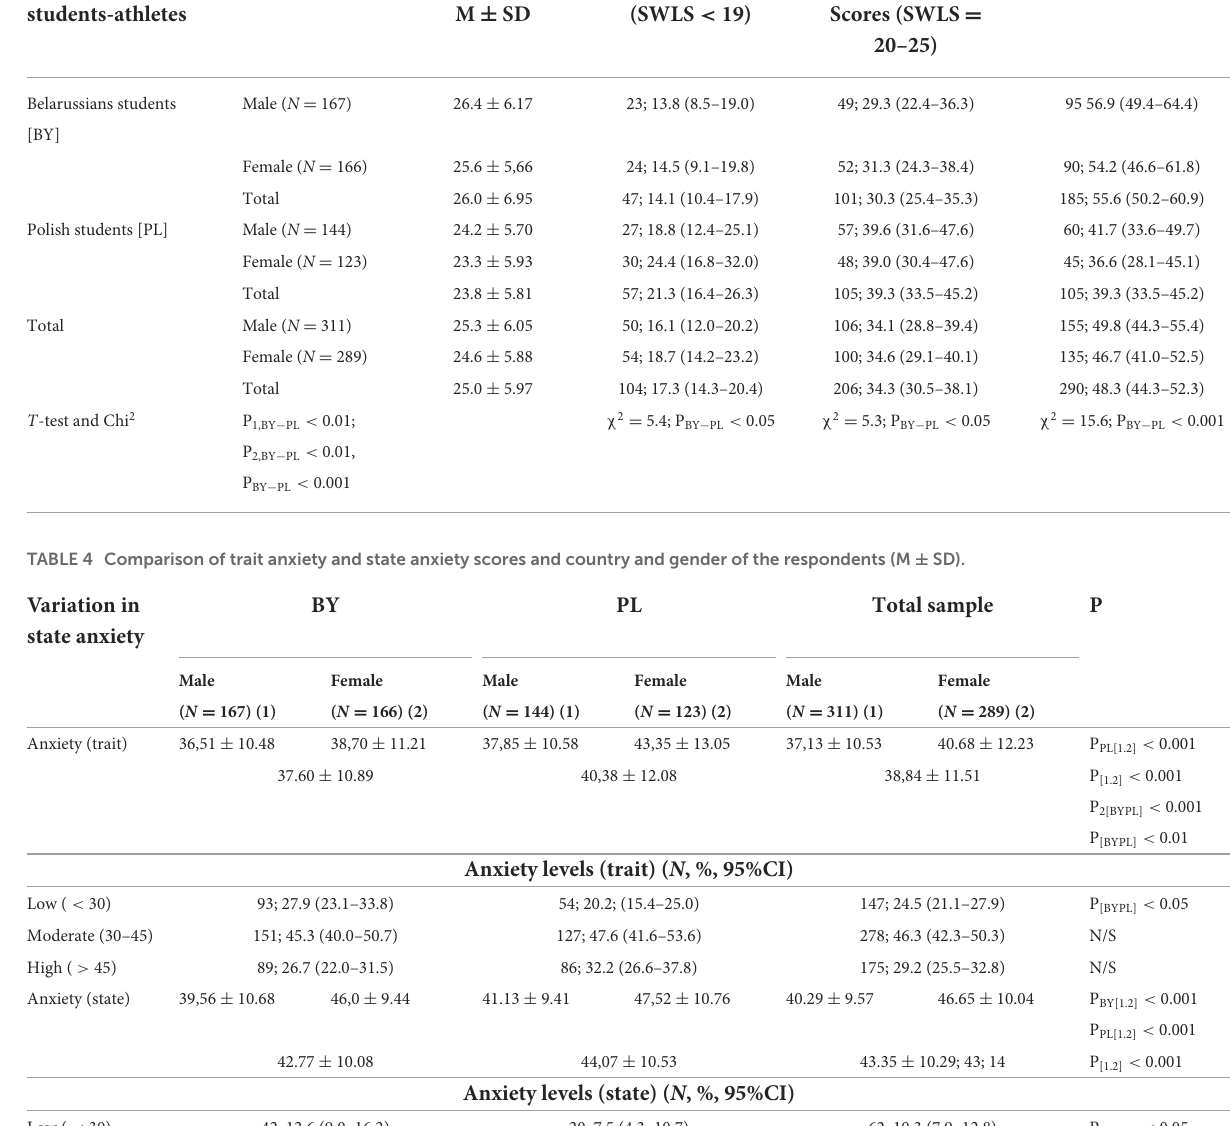
TABLE 3 SWLS scores for study groups by gender and country (N, %, 95%CI). Groups of